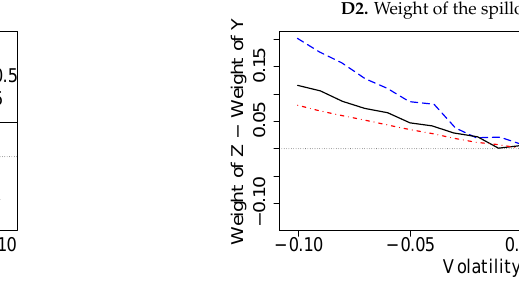
Figure 8. Volatility spillovers and portfolio optimization. This figure presents the differences in characteristics of portfolios formed by daily returns ( A , B ) or by weekly returns ( C , D ) with and without daily volatility spillover. Panels A and C present the differences in standard deviation and in the weight of the spillover-receiving asset in the minimum variance portfolios. Panels B and D present the differences in Sharpe ratio and in the weight of the spillover-receiving asset of the portfolio targeting maximum Sharpe ratio. We use “daily” and “weekly” for the illustration purpose; the results also apply to other relative “high” and “low”